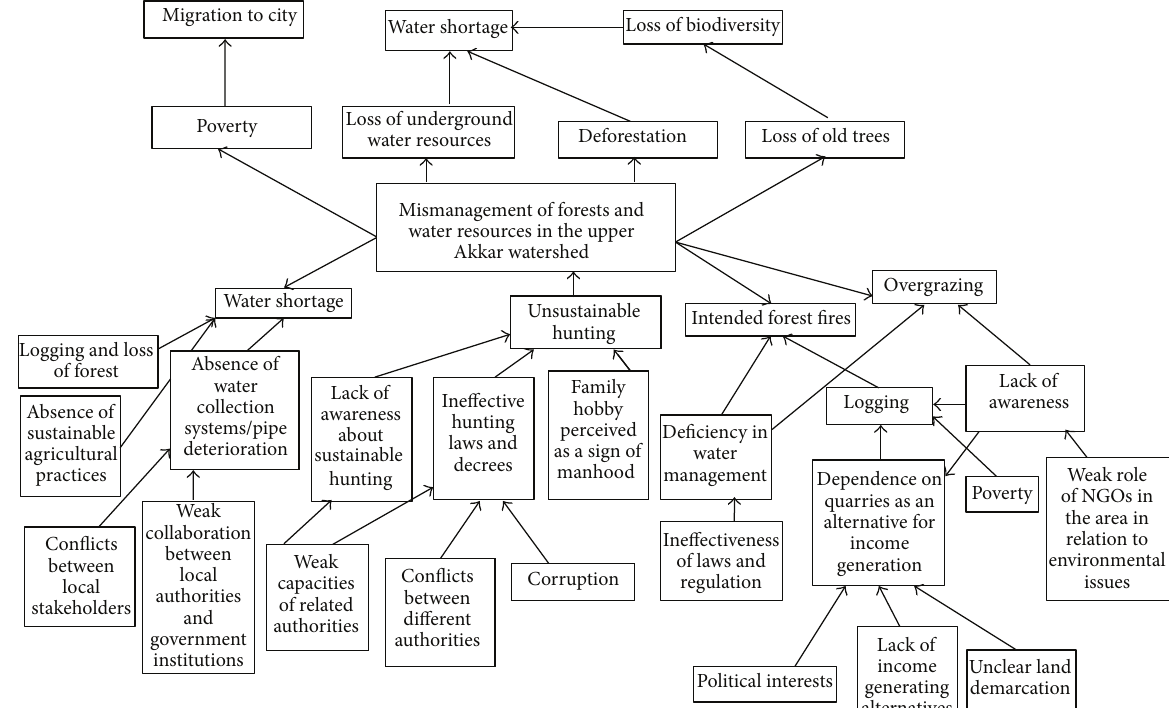
Figure 2: Problem tree for mismanagement of forests and water resources in the upper Akkar watershed.